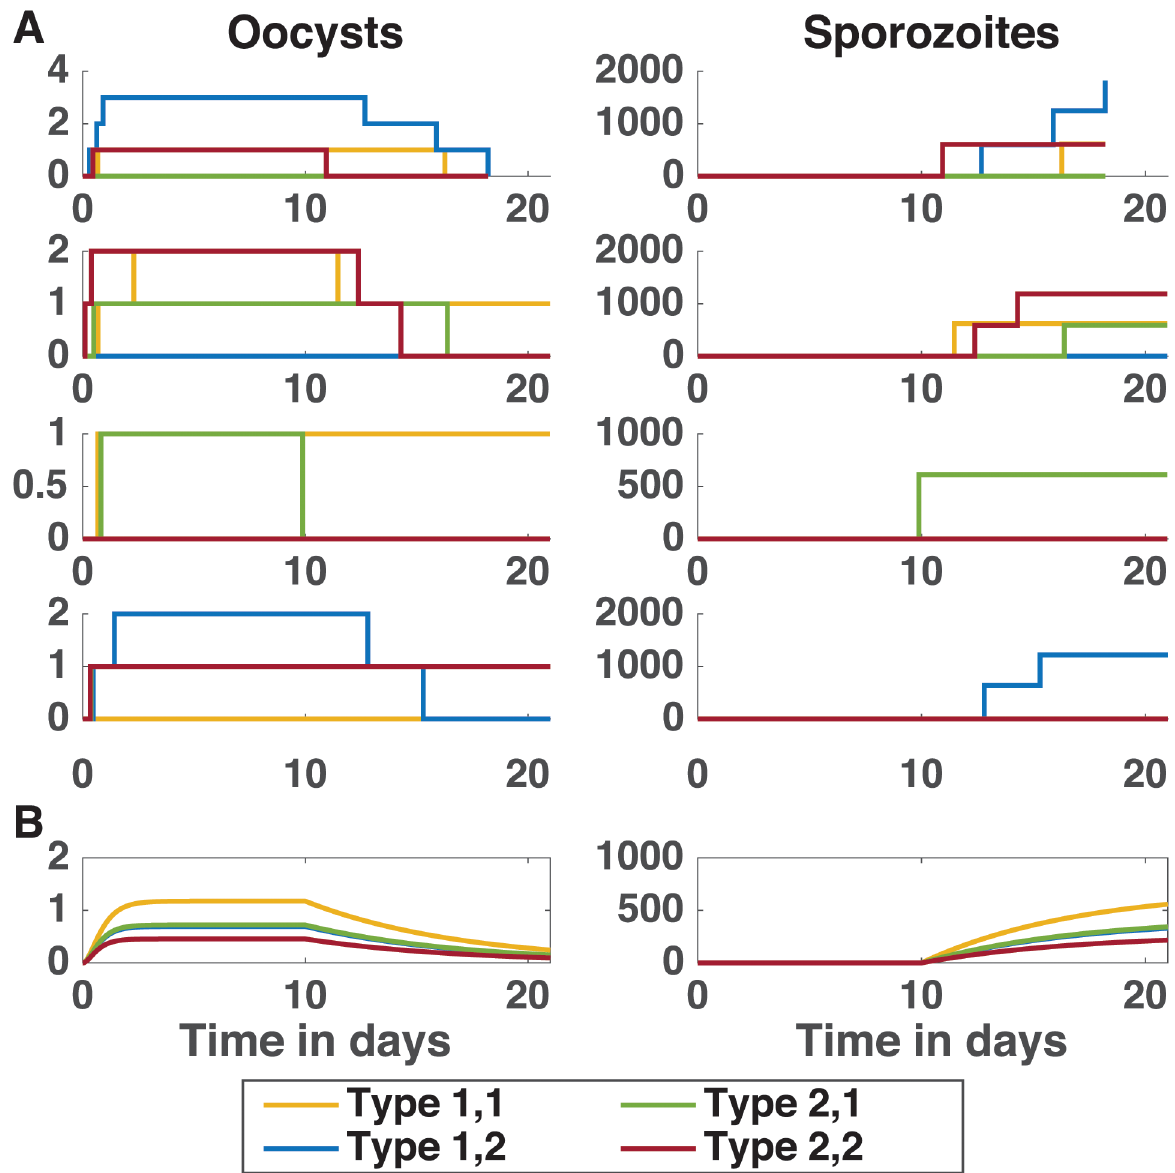
Fig 3. Comparison of stochastic and deterministic dynamics of oocysts and sporozoites. (A) Each of the first four rows illustrate the dynamics of the oocyst (left column) and sporozoite(right column)populationsfrom individualsimulations of the CTMC model using 50% fitness bias and G 0 = 300. (B) The dynamics of the deterministic model for oocysts (left) and sporozoites (right). Observe the variation in dynamics possiblewith the CTMC